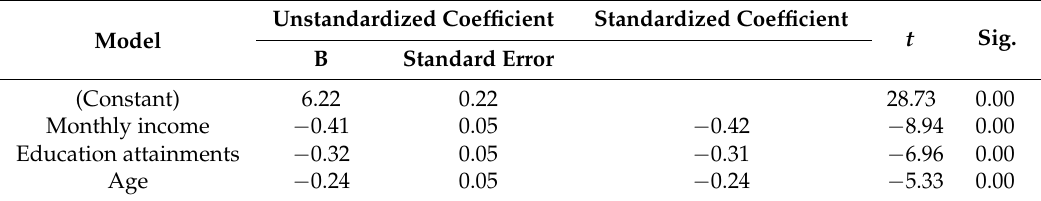
Table 11. Results of linear regression